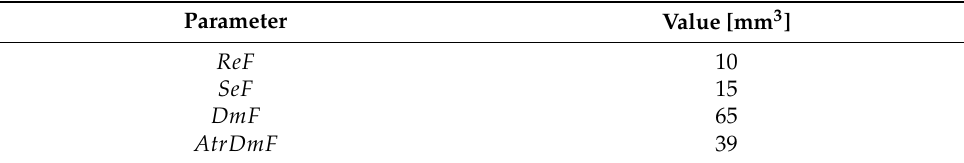
Table 4. Scaling